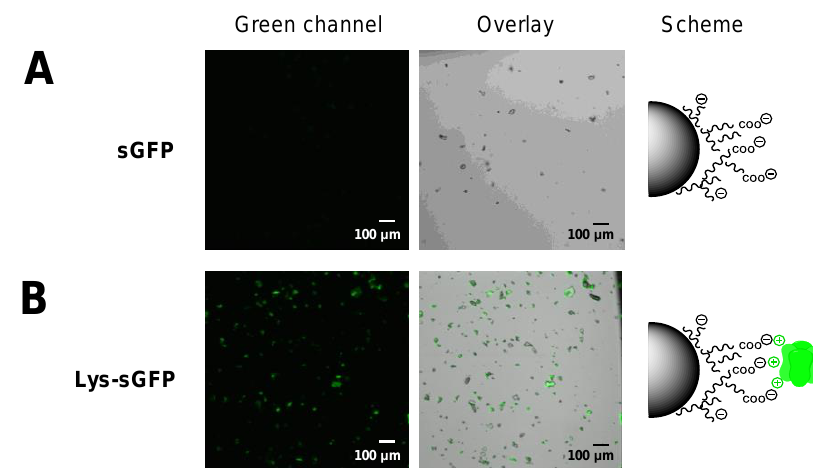
Figure 7. CLSM of Lys-sGFP immobilized on alginate-coated upconverting nanoparticles (UCNPs) after sample washing. ( A ) Untagged sGFP was incubated with UCNPs decorated with alginate. ( B ) Lys-sGFP immobilized on UCNPs decorated with alginate through ionic interactions. From left to right: green channel (λ ex : 488 nm, λ em : LP505 nm), overlay of fluorescence and brightfield signals, and the scheme of the protein immobilization.